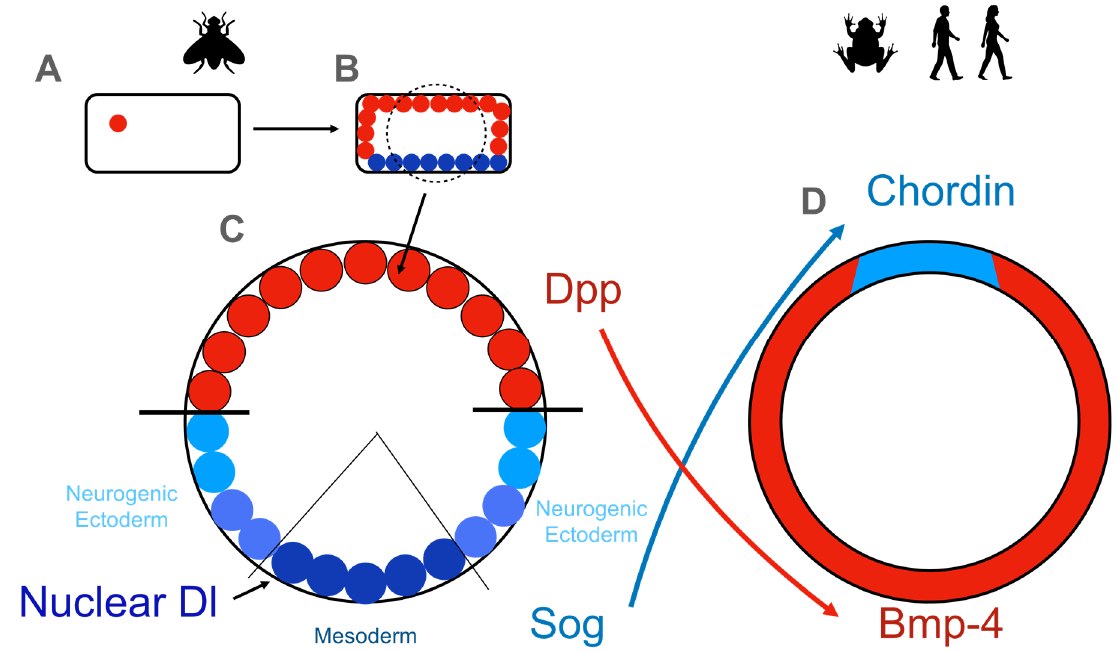
Figure 2. Schematic view of the fly Drosophila melanogaster’s development (in ( A – C )), also shown in comparison to that of vertebrates such as the frog Xenopus laevis and humans (in ( D )). A fertilized Drosophila egg ( A ) starts to divide and forms an embryo where the cytoplasm is shared between all nuclei (syncytium, ( B )). At this stage of development, a dorsoventral gradient initiates the nuclear localization of Dorsal (Dl, blue), which is the fly homolog of vertebrate NF-κB. Dl is nuclear in the ventral region, as can be seen in the cross-section of the fly embryo depicted in ( C ). Nuclei without Dl are depicted in red, and a graded amount of nuclear Dorsal is depicted in shades of blue, with the maximal Dl concentration in dark blue. Extracellular regulators such as Decapentaplegic (Dpp) inhibit nuclear orsal, whereas Dpp is inhibited by its antagonist Sog (short gastrulation protein). Vertebrates do not have a ventral nerve cord but have a spinal cord; thus, it would not be entirely surprising if molecular regulators were also turned in their orientation from ventral to dorsal. BMP-4, a homolog of Dpp, is expressed in the ventral domain ( D ), whereas Chordin, a homolog of Sog, is expressed in the dorsal domain.